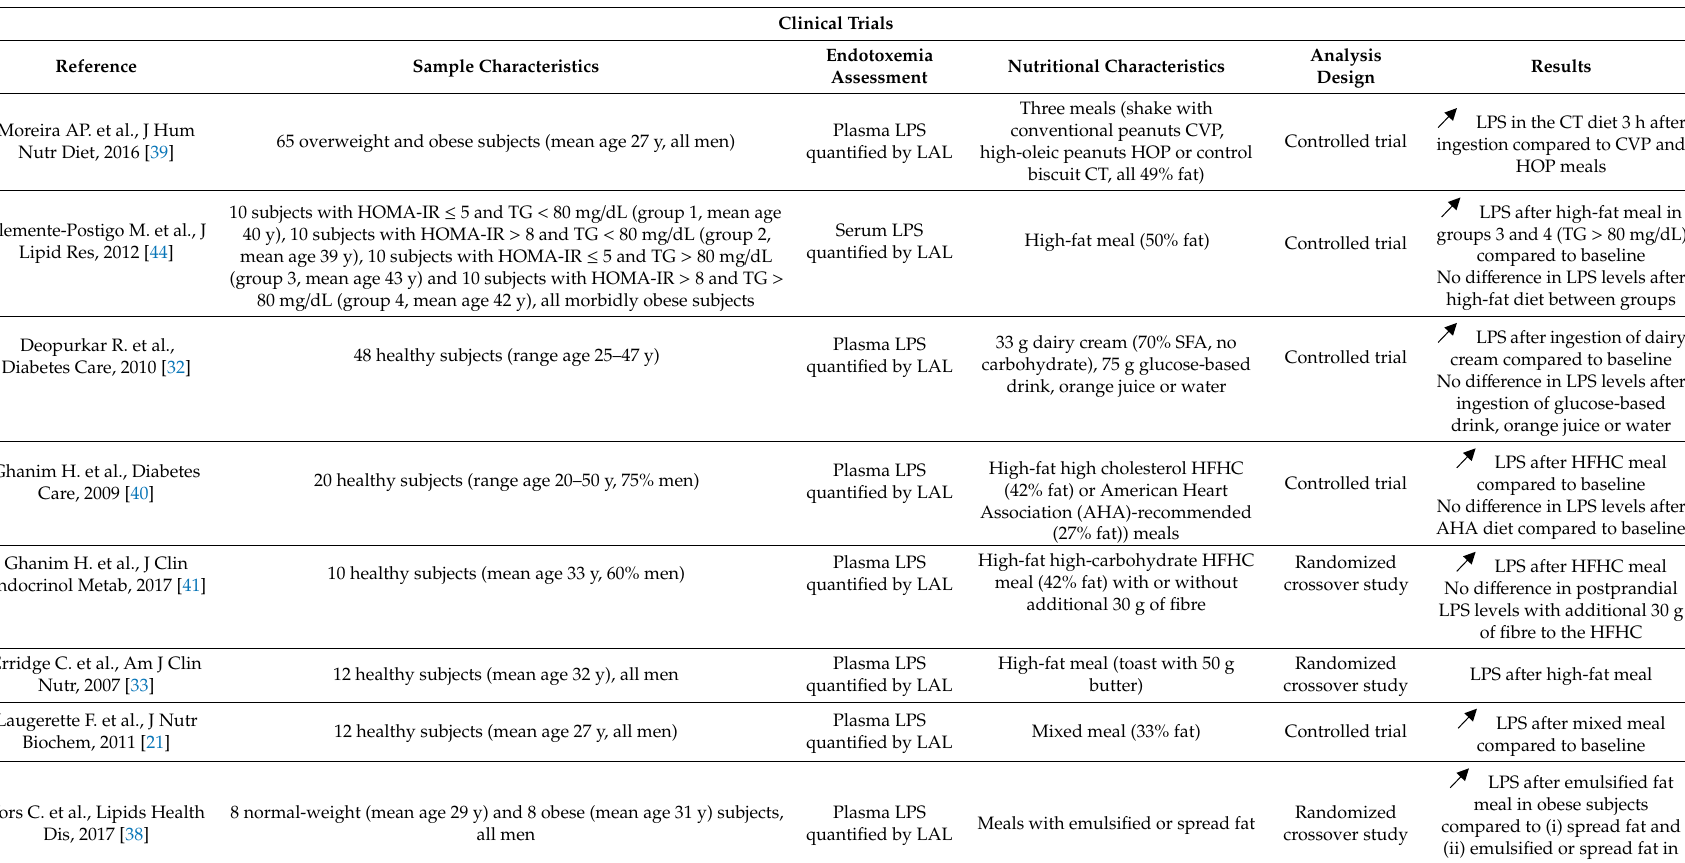
Table 1. Selective evidence on the association between a single high-fat meal and metabolic endotoxemia. Table 1. Cont.